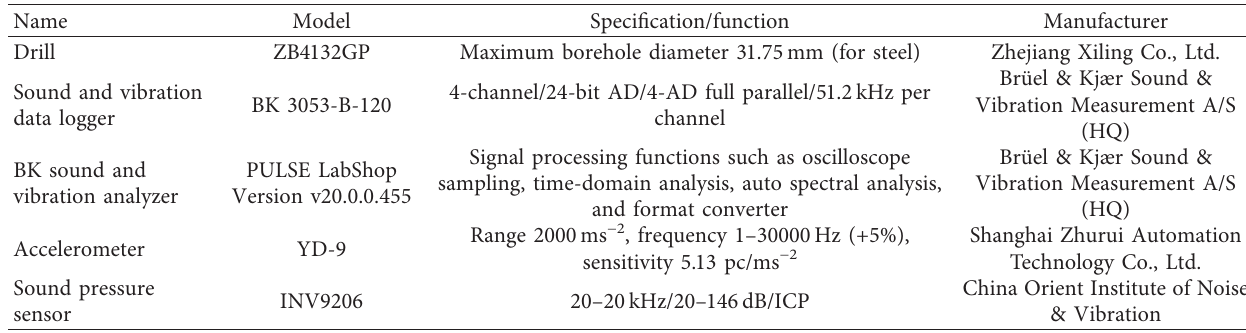
Figure 2: Drilling and sound/vibration signal acquisition system. Table 2: Specifications of the experimental